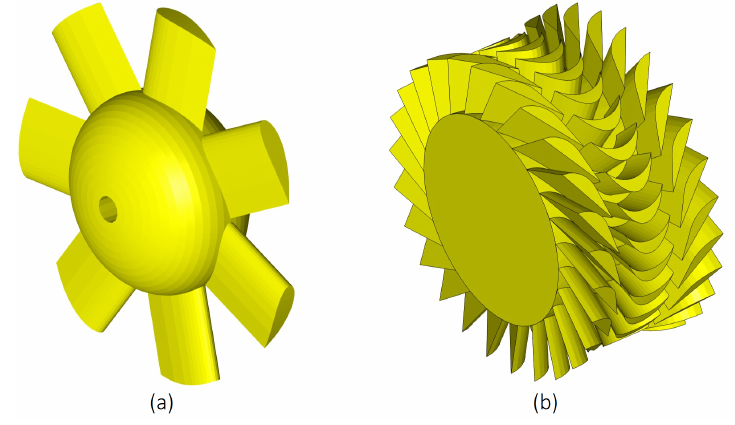
Figure 4. Self rectifying axial turbines: Wells turbine without guide vanes ( a ) and impulse turbine ( b